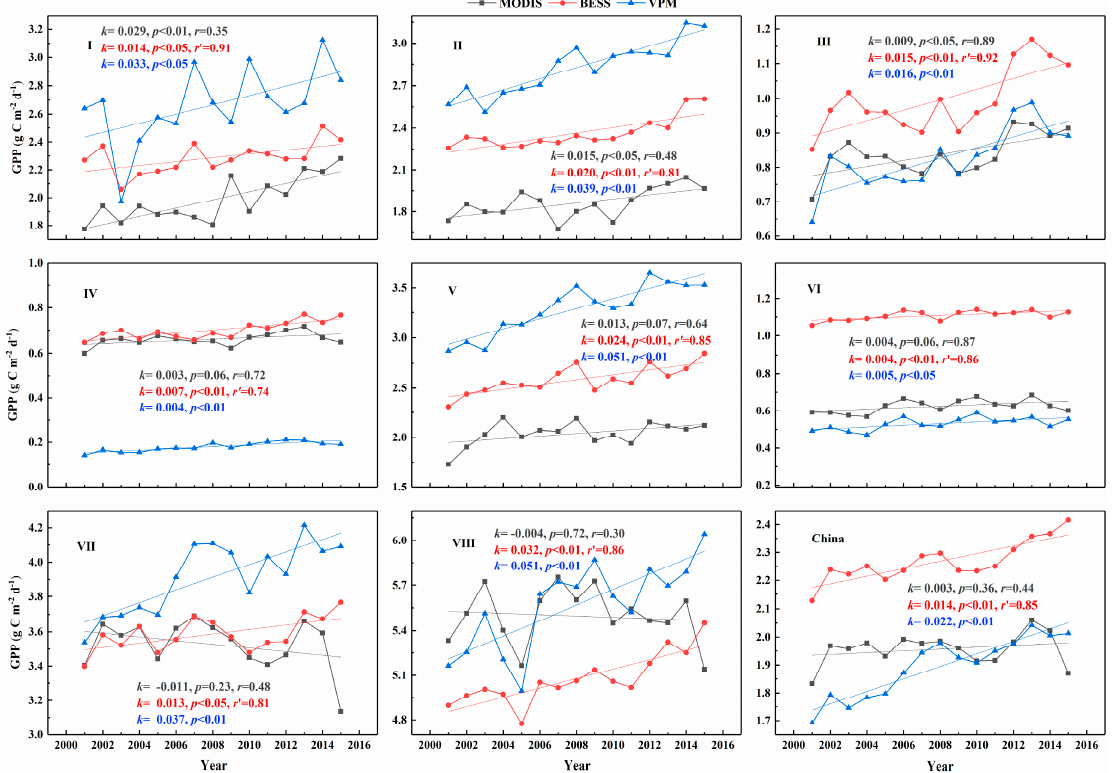
Figure 6. Interannual dynamics of the average MODIS GPP, BESS GPP, and VPM GPP over the eight climatic zones from 2001 to 2015 with linear trend k and significance levels ( p < 0.01 is highly significant, and p < 0.05 is significant); r and r’ represented the correlations between the auxiliary VPM GPP with the MODIS and BESS GPP, respectively.